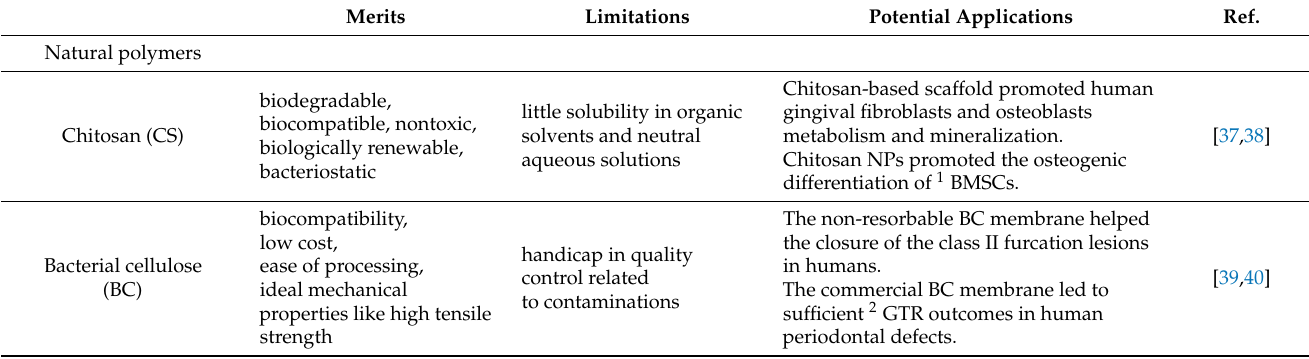
Table 1. List of selected polymers and bioceramics in nanofibers for periodontal